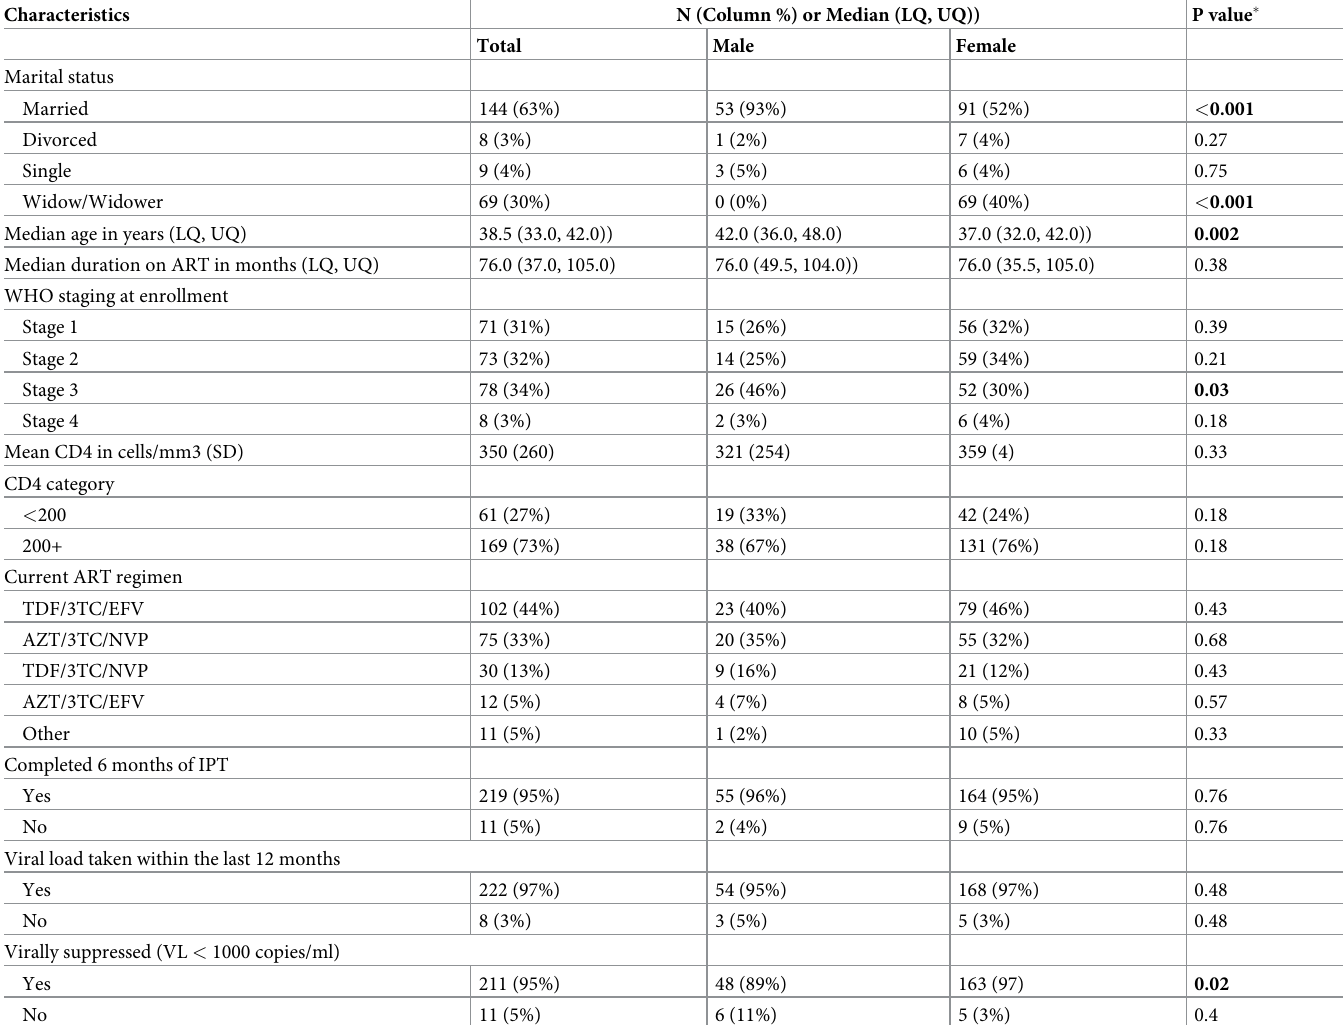
Table 2. Sex-specific characteristics of 230 HIV-positive PEs in 140 sites in Kenya.